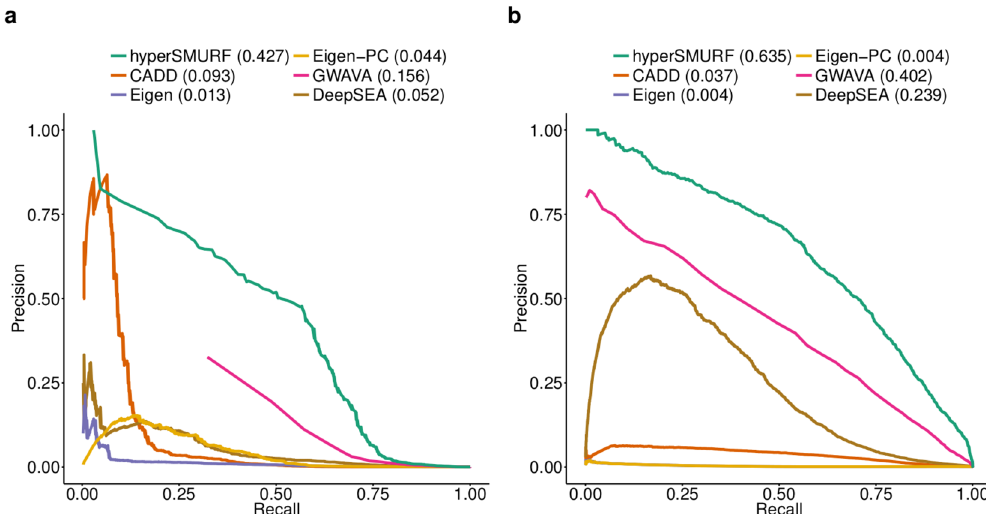
Figure 4. Comparison of the precision/recall curves (PRC) across methods. ( a ) PRC with Mendelian regulatory mutations. ( b ) PRC with GWAS regulatory hits. Numbers in parentheses represent AUPRC